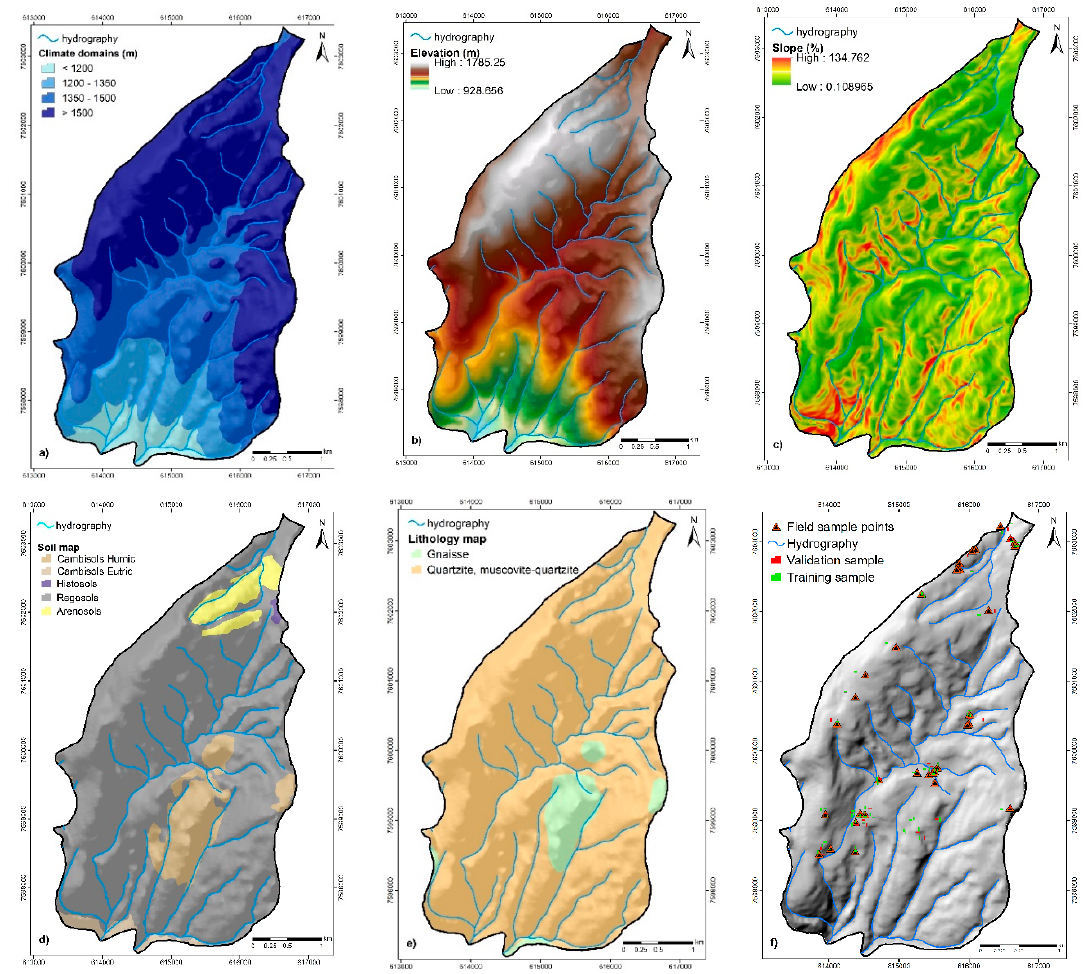
Figure 2. Thematic maps: ( a ) climate domains, adapted from [35]; ( b ) elevation (m); ( c ) slope (%); ( d ) soil map, adapted from [40]; ( e ) geological map, adapted from [17,41]; ( f ) field sampling points.